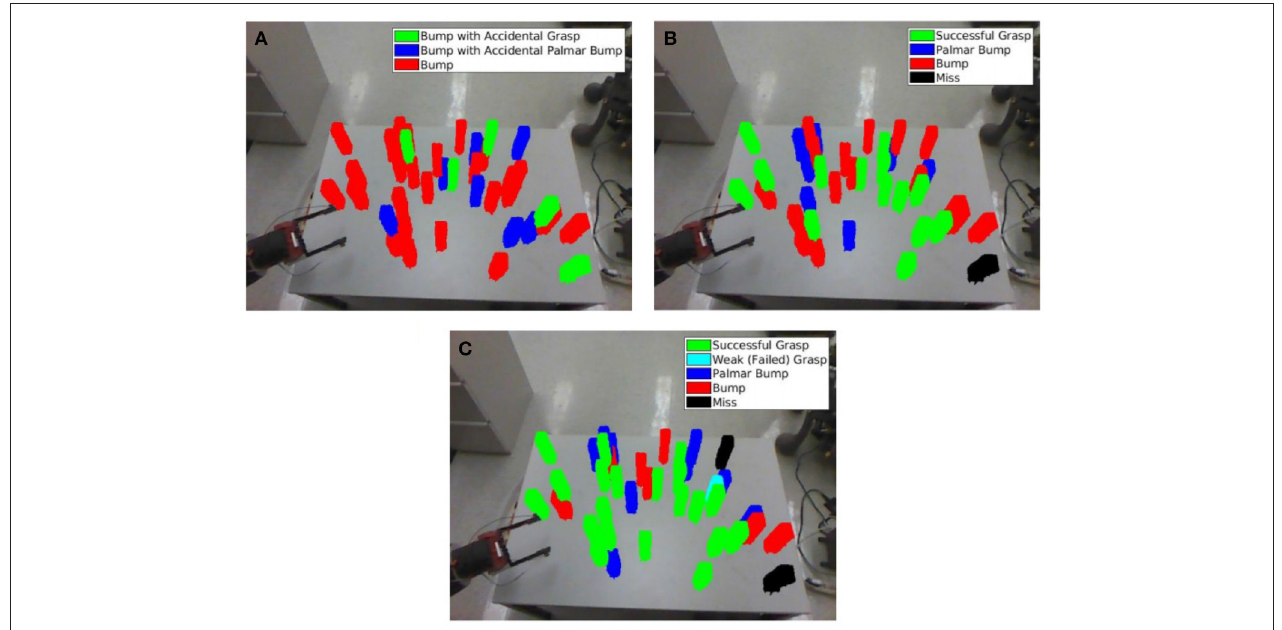
FIGURE 12 | Spatial representations of the results of three methods for the agent’s learned reach and grasp actions. Each shows a superposition of all placements of the single target object, colored according to the result of the agent’s attempt to repeat an unusual event by executing a motion trajectory. (A) Experiment 8 uses the final reaching trajectories of section 4.3 to successfully repeat the bump event for all target placements. Twelve of these reaches accidentally trigger the Palmar reflex, five of which become early examples of grasps. (B) Using cosine similarity features in Experiment 11 (section 5.3), the agent modifies the final approach so that this motion causes significantly more Palmar bumps and more grasps are also observed. (C) In results from experiment 12, the agent grasped from additional placements by changing the angle of the most distal joint, w2. The wrist orientation is copied from the final configuration of a trajectory that succeeded for a nearby placement (section 5.4). The use of nearest neighbors applies best very close to existing successes, so most improvements can be observed in these